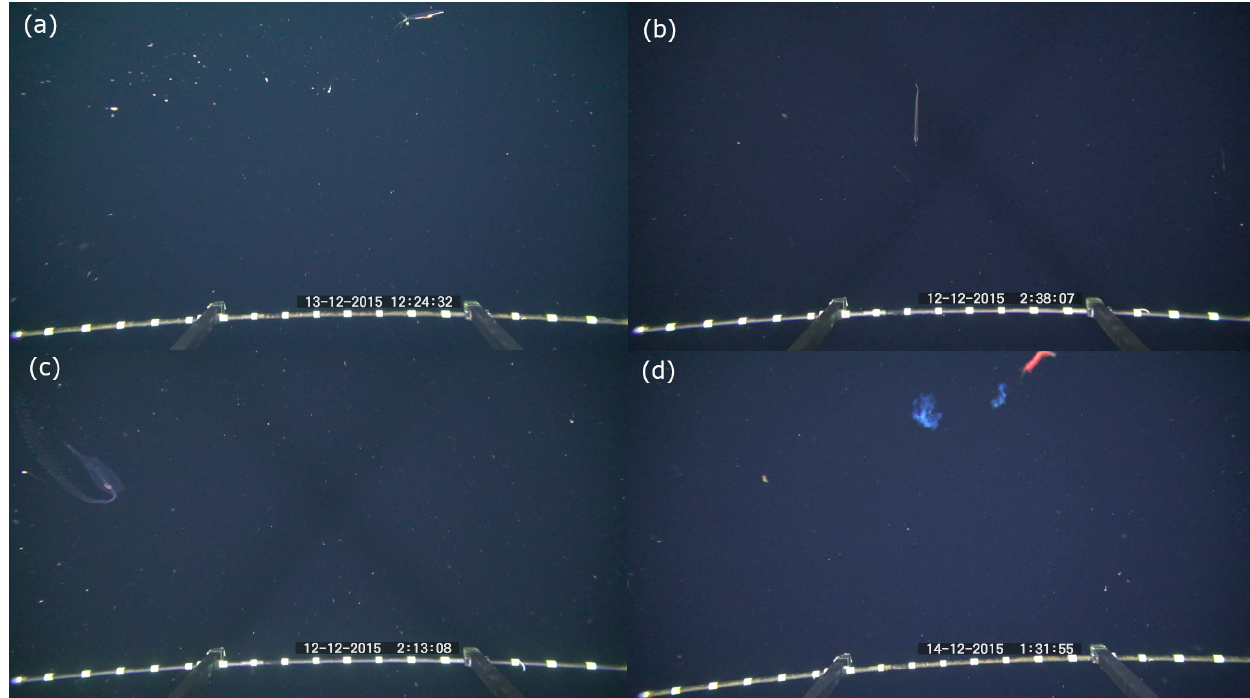
Figure 6. Examples of behaviors observed during pelagic video transects with the PELAGIOS. (a) Poeobius sp. in a feeding position with a mucus web (left side of the animal); (b) a dragonfish of the family Stomiidae in a vertical position; (c) a salp releasing a blastozoid chain; (d) a crustacean releasing two bioluminescent clouds while performing an escape response. The distance between the white bands on the horizontal bar on the bottom of the images is